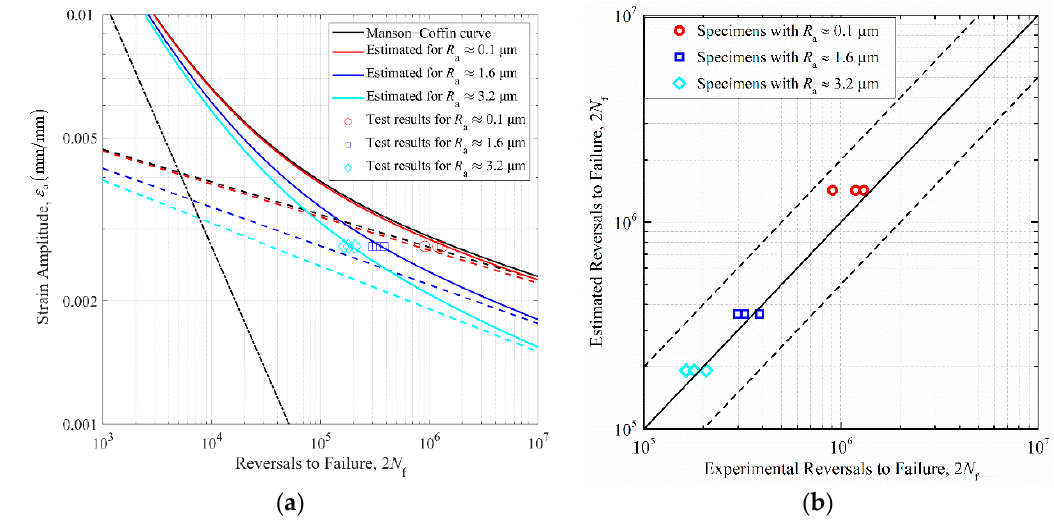
Figure 10. ( a ) Strain–life curve for 42CrMo steel and estimated curve for rough specimens based on correcting the elastic strain behavior using the average K f induced by surface topographies. ( b ) Estimated fatigue lives compared to experimentally obtained fatigue lives with the scatter bands of